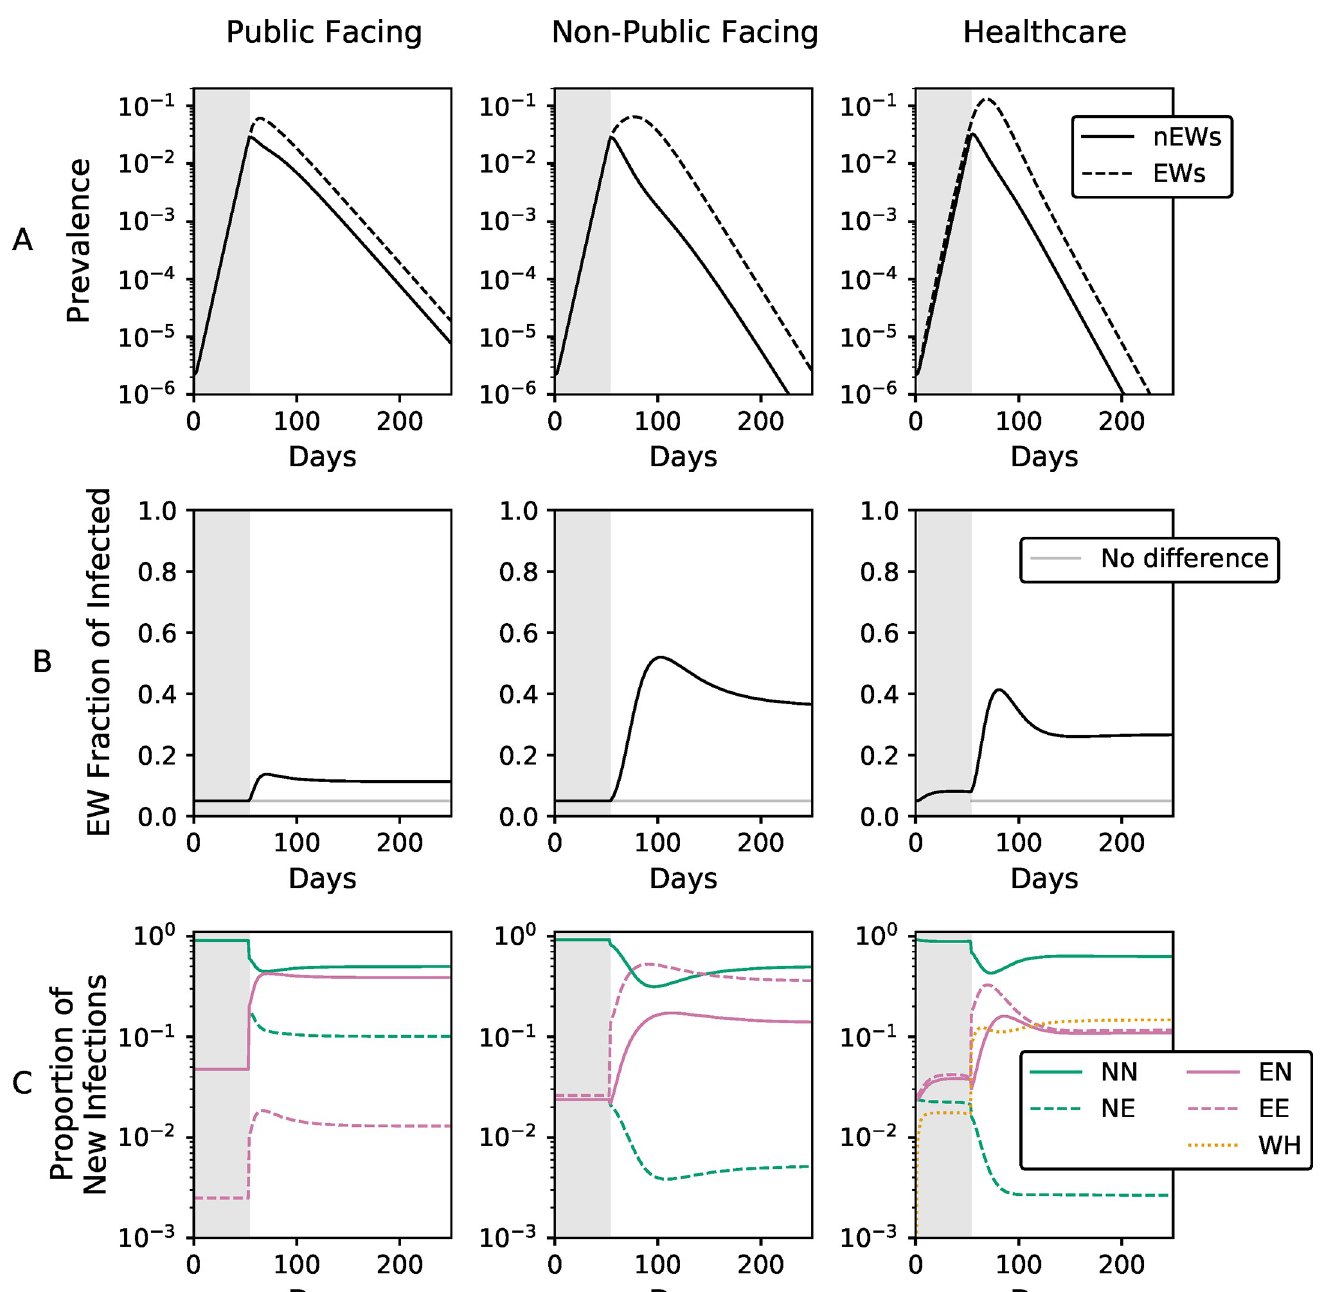
Fig 4. Time resolved dynamics of infections, for f = 0.05 and R 0 θ = 0.5. Times before the implementation of SIP (day 53) are denoted by the grey shade. A) Time- resolved proportion of EWs (dashed lines) and nEWs (solid lines) that are infected. B) The fraction of infected individuals that are EWs. Prior to SIP, this fraction is f , except in the healthcare model where EWs also become infected from individuals within the hospital compartments. After SIP, this fraction increases, i . e ., EWs bear a proportionally larger burden of the epidemic. C) Where new infections originate. SIP reorganizes the flow of infections through the subpopulations in a model-dependent manner. The acronyms denote different types of transmission, with the first and second letters denoting the infecting and the infected subpopulation respectively (e.g., EN is infections from EWs to nEWs); WH refers to infections that occur within hospitals. For equivalent figures with alternative choices of parameter values, see Section 4 and Figs 30–46 in S1